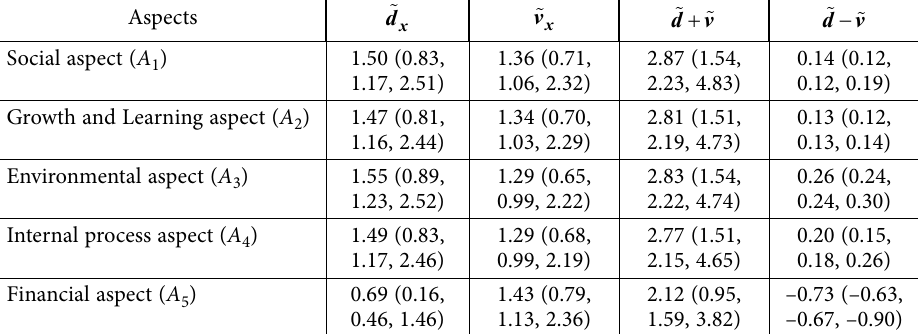
Table 6. Total influence prominence and net influence with fuzzy number and defuzzication